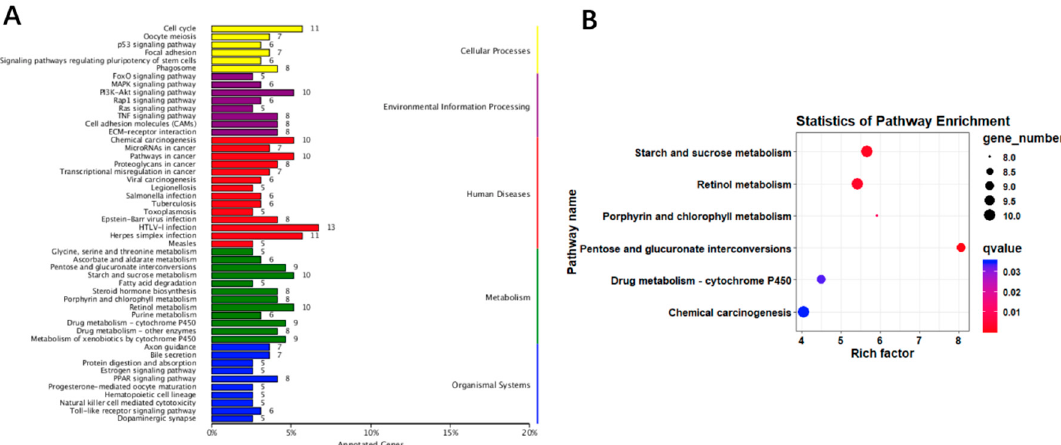
Figure 8. Prediction and functional analysis of target genes regulated by di ff erentially expressed mRNAs between the control and experimental group. ( A ) KEGG classification map of the di ff erentially expressed genes. ( B ) Scatter plot of KEGG pathways enriched in the di ff erentially expressed genes.